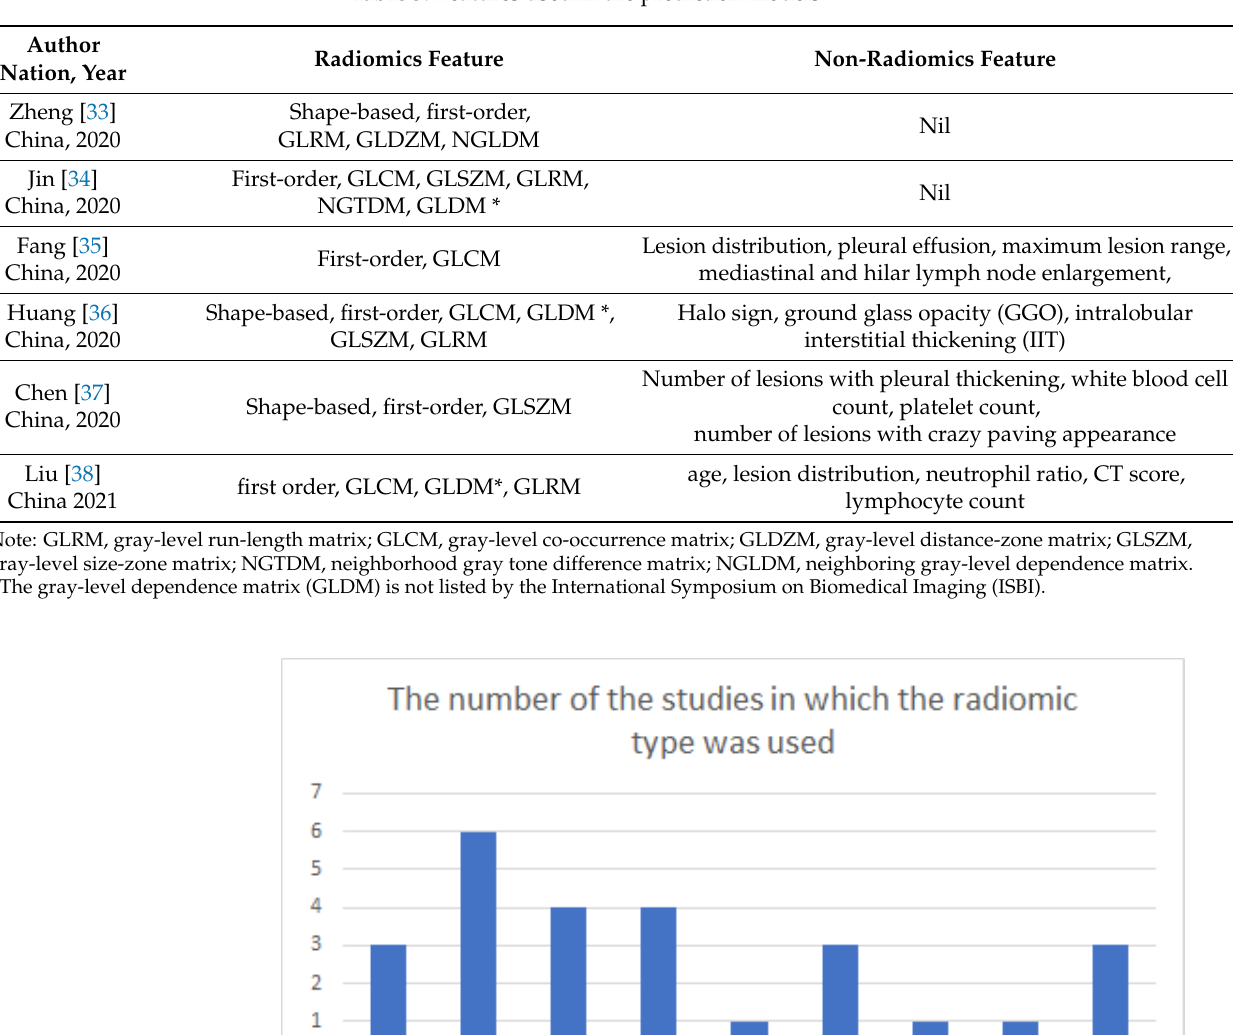
Table 3. Features used in the prediction models.